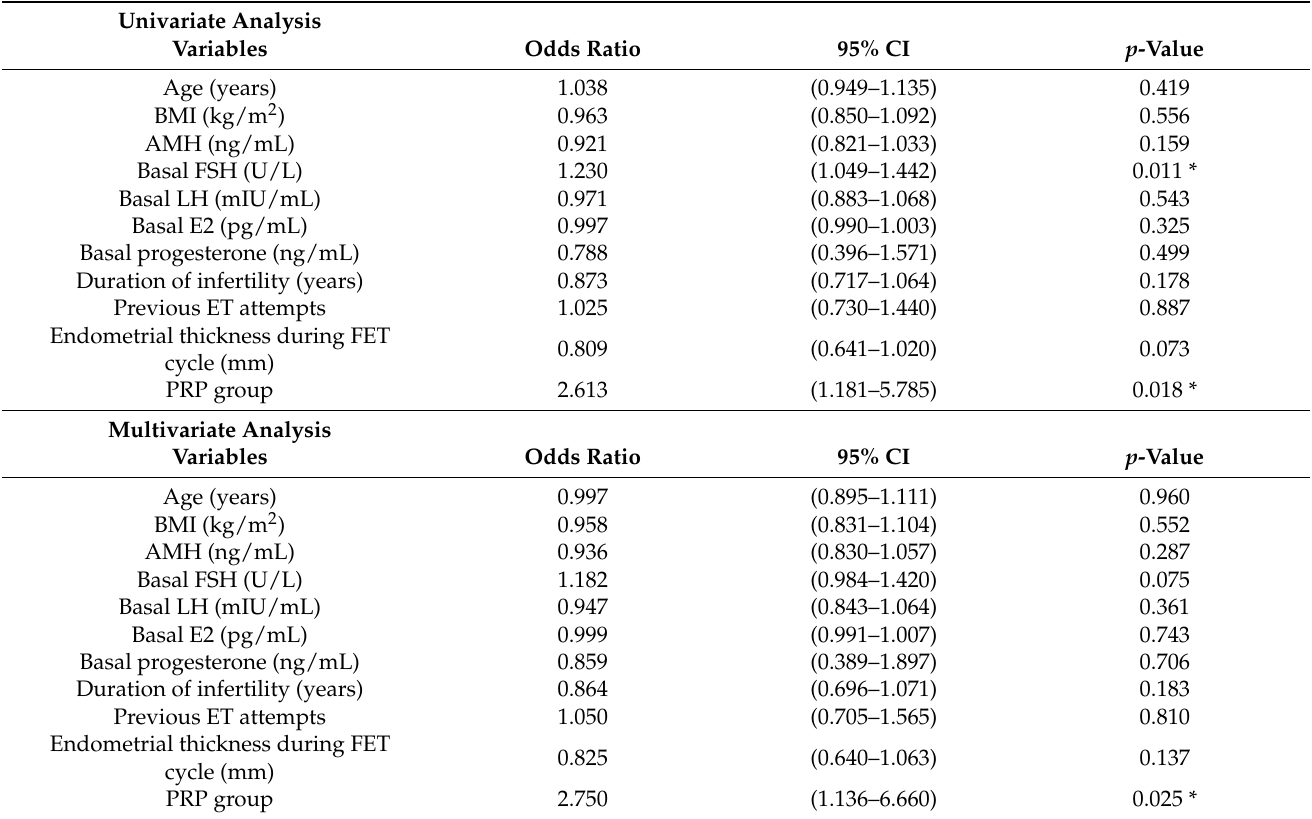
BMI: body mass index, AMH: anti-Mullerian hormone, FSH: follicle-stimulating hormone, LH: luteinizing hormone, E2: estradiol, ET: embryo transfer, FET: frozen embryo transfer, β -hCG+: beta hCG-positive, PRP: platelet-rich plasma. * Statistically significant at p <